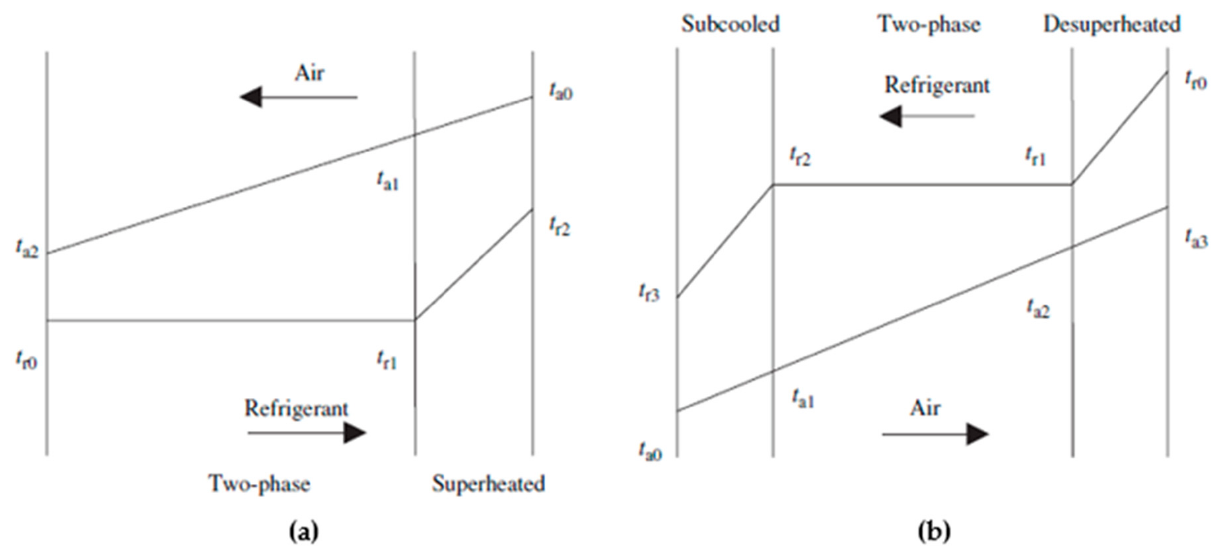
Figure 14. Temperature distribution of a counter flow evaporator ( a ) and condenser ( b ) [82].